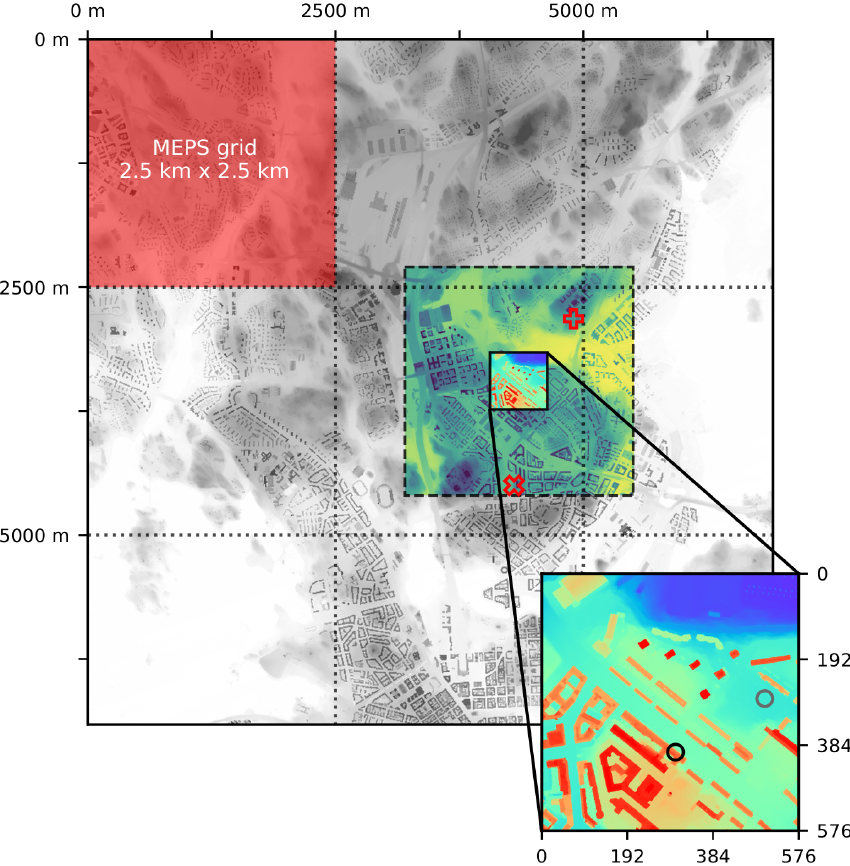
Figure 1. The modelling domain: root in grey, parent in viridis (dashed line) and child in rainbow (solid line). The grid size of the MEPS data is illustrated with a red area and dotted lines. The background air quality monitoring sites are marked with an empty red + sign (SMEAR III) and an empty red × sign (Kallio). In the zoomed figure over the child domain, the supersite is marked with a black circle and the background measurement point of the Sniffer mobile laboratory with a grey